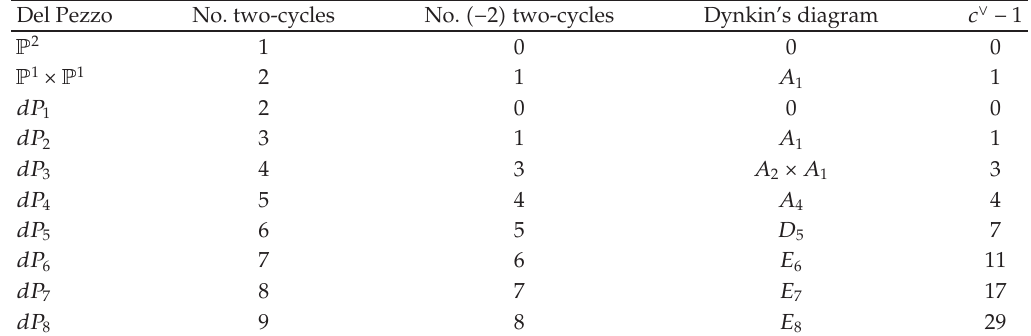
Table 1: Some characteristics of del Pezzo surfaces.